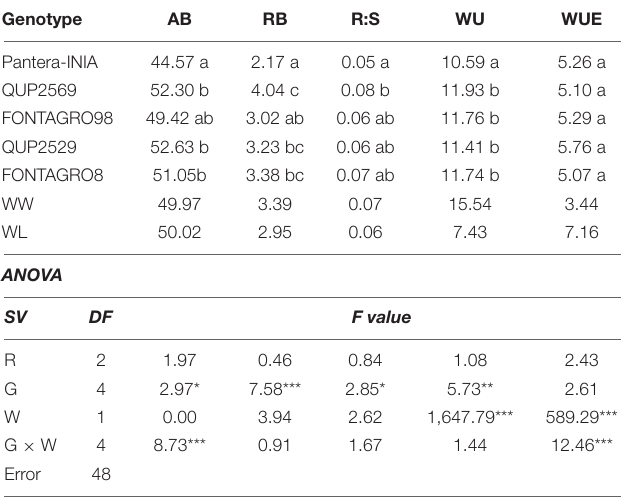
TABLE 3 | Aerial biomass (AB, g), root biomass (RB, g), root:shoot ratio (R:S), water use (WU, L), and water use efficiency (WUE, g L − 1 ) under well-watered (WW) and water-limited (WL) conditions–2017 trial.